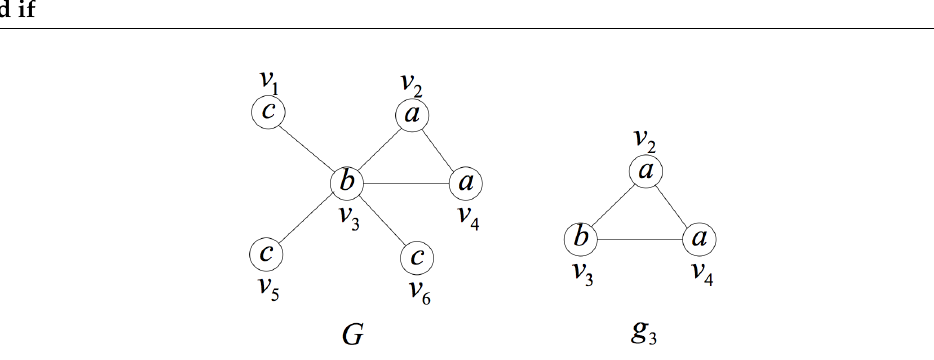
Figure 5. An example to show the self-isomorphism